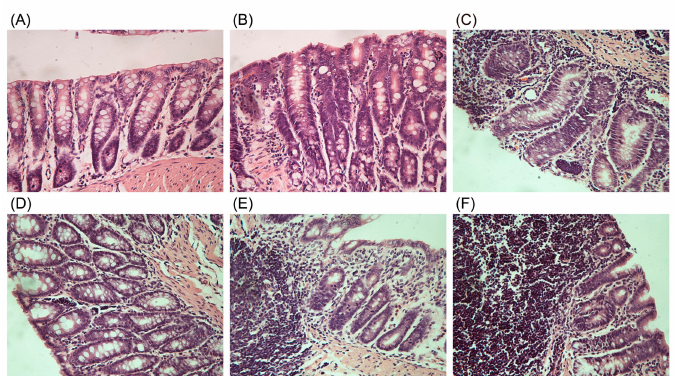
Figure 4. The H&E staining on the colons collected from the untreated rats and treated rats for over six days (original magnification 40 × ). ( A ) The colon from normal control rats (NC). ( B ) The colon from rats treated with the low dose of senna extract (L-SE). ( C ) The colon from rats treated with the high dose of senna extract (H-SE). ( D ) The colon from rats treated with the low dose of sennosides (L-SS). ( E ) The colon from rats treated with the high dose of sennosides (H-SS). ( F ) The colon from rats treated with the high dose of sennoside A (SA).